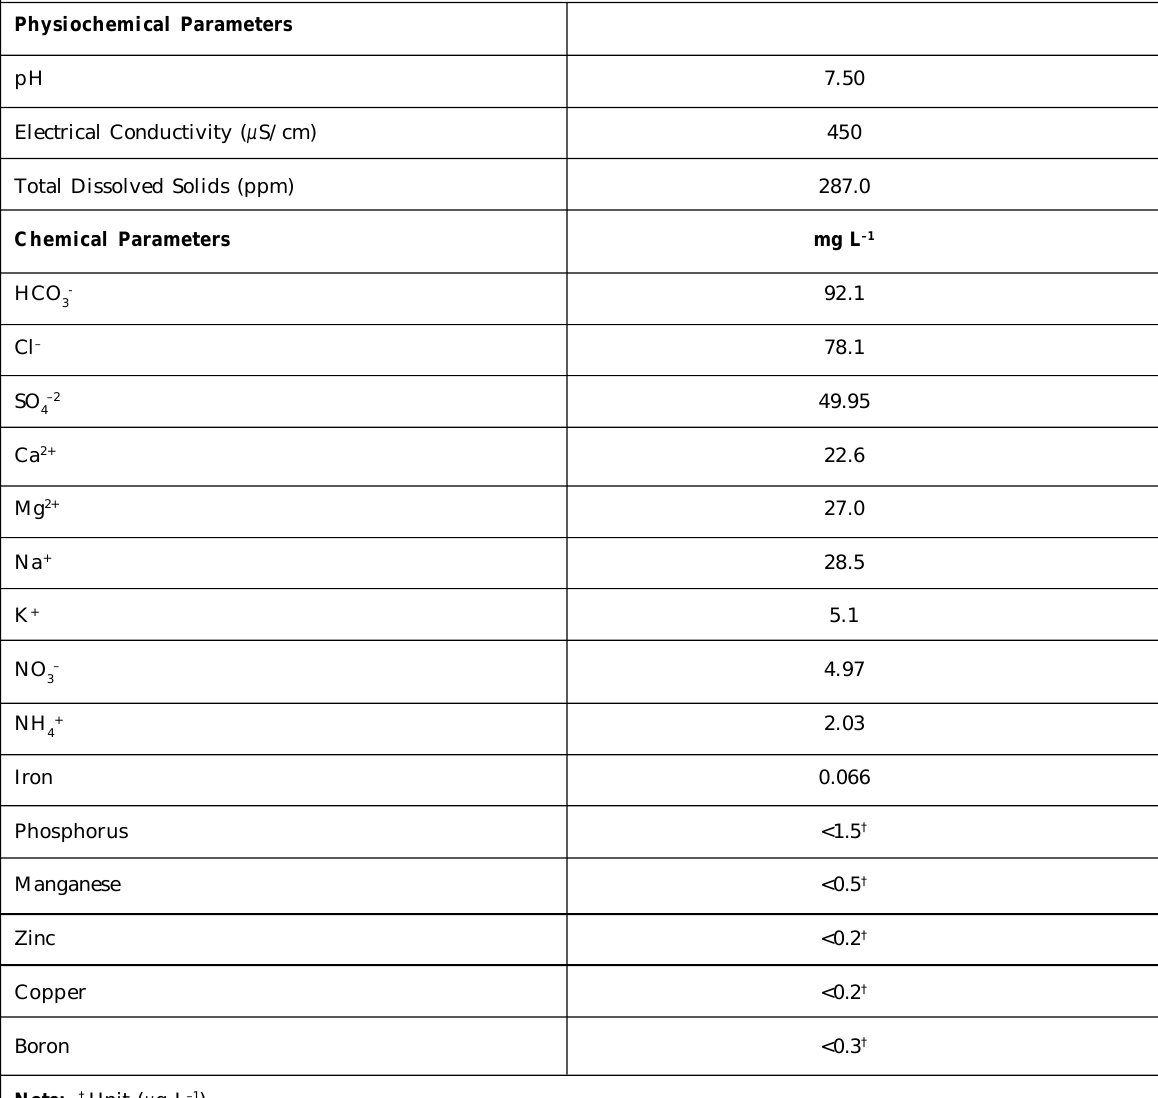
Table 2: Physicochemical analysis of the water samples collected from Cairo governate, Egypt Physiochemical Parameters